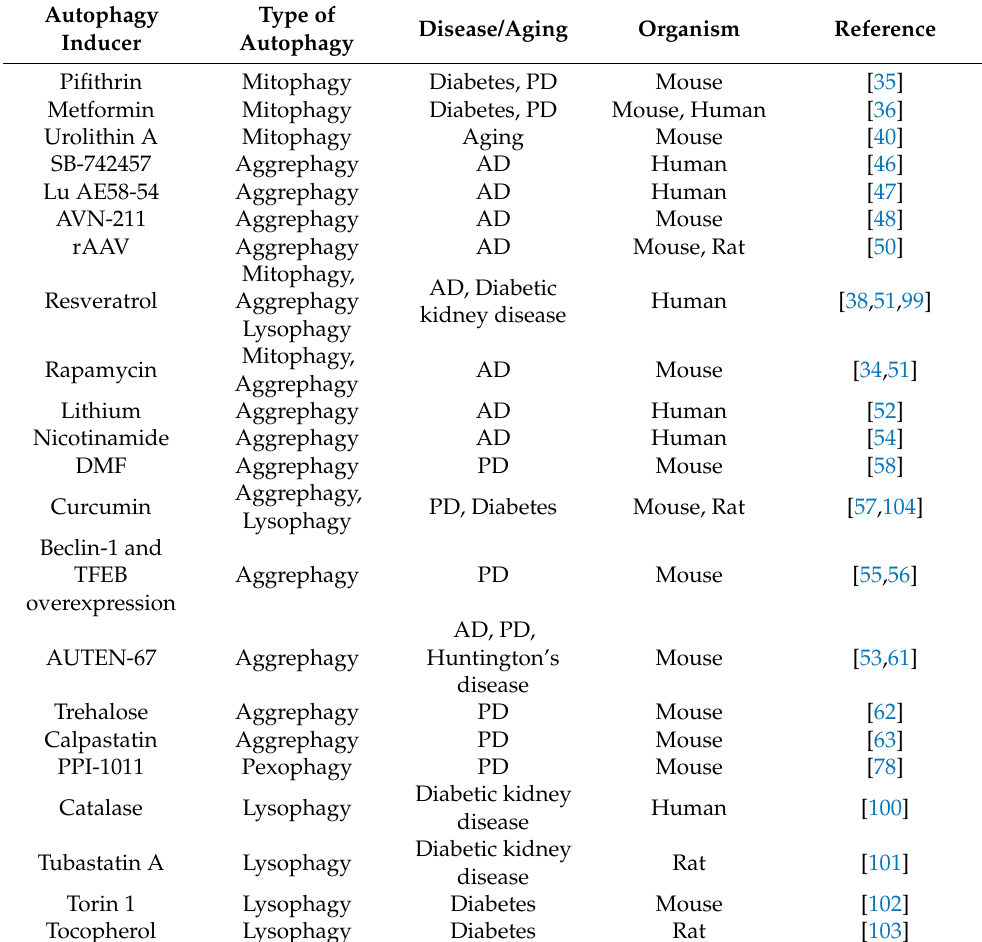
Table 1. Association of selective autophagy inducers with disease therapy or